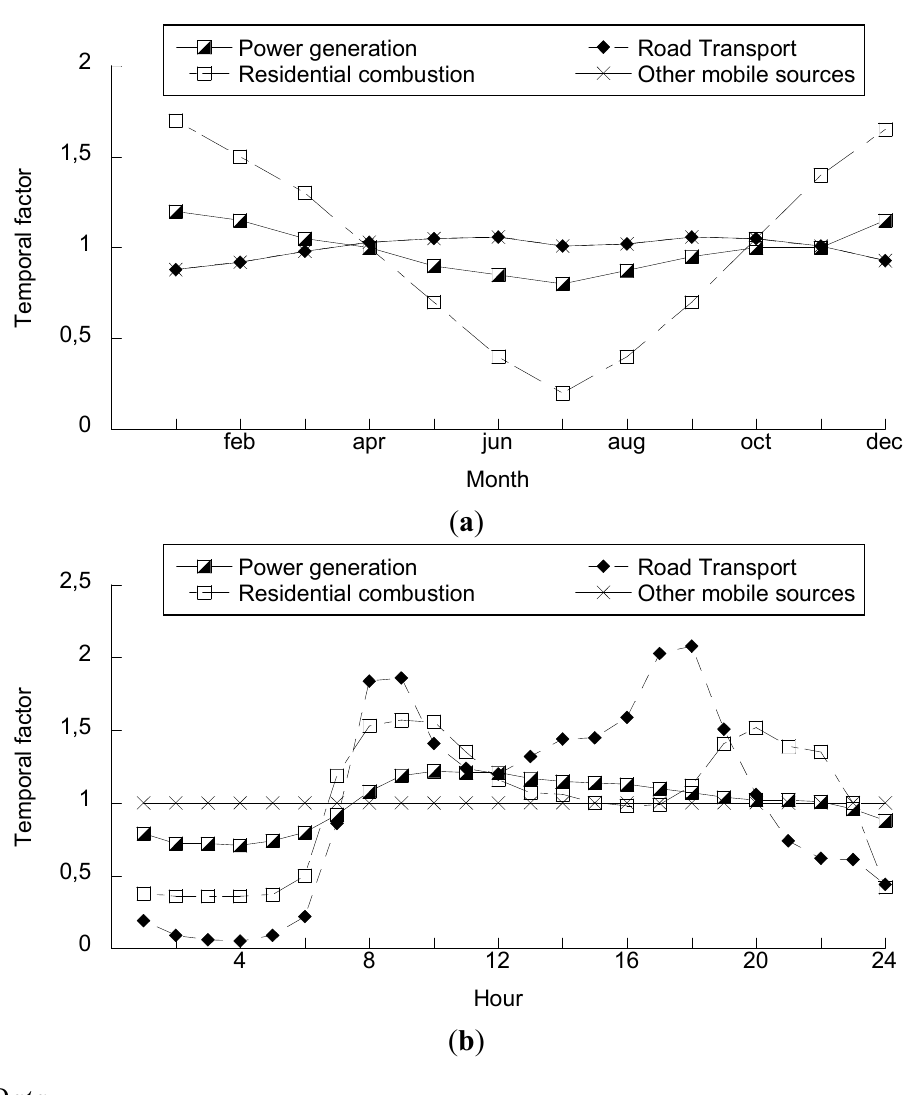
Figure 1. Temporal profiles for the seasonal ( a ) and diurnal variation ( b ) for the power sector, road transport, other mobile sources and the residential